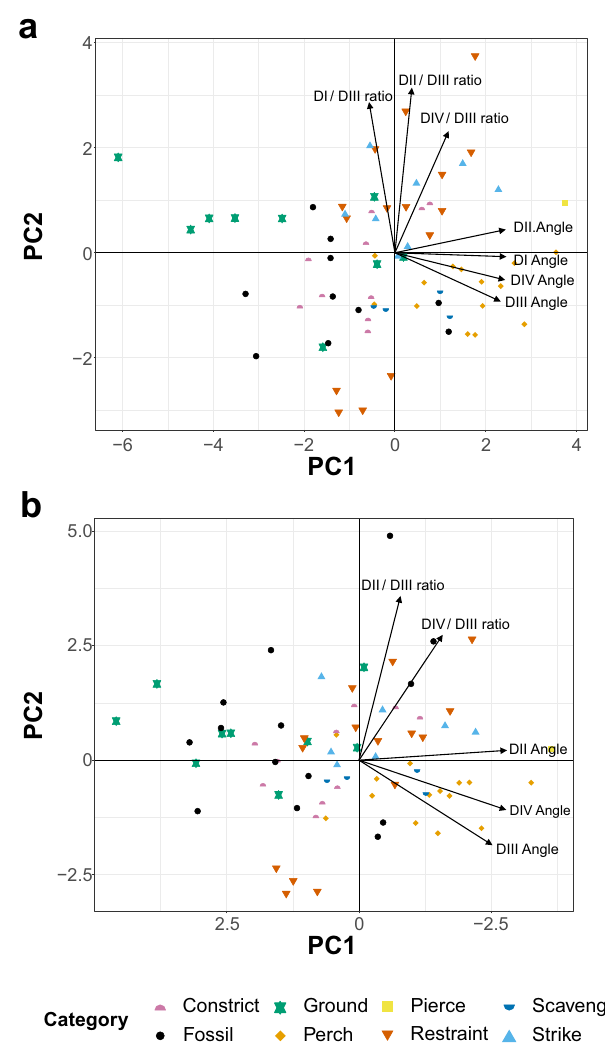
Fig. 8 | Plot of character weightings for the graphs in Fig. 7. Plots are provided fordatasets with a digitI included and b excluded.In bothplots, PC1 isdominated byclawcurvaturewhereincreasedcurvaturecorrespondstoincreasingPC1values, andPC2isdominatedbyincreasingratiosofarclengthsofdigitsI,II,andIVrelative to digit